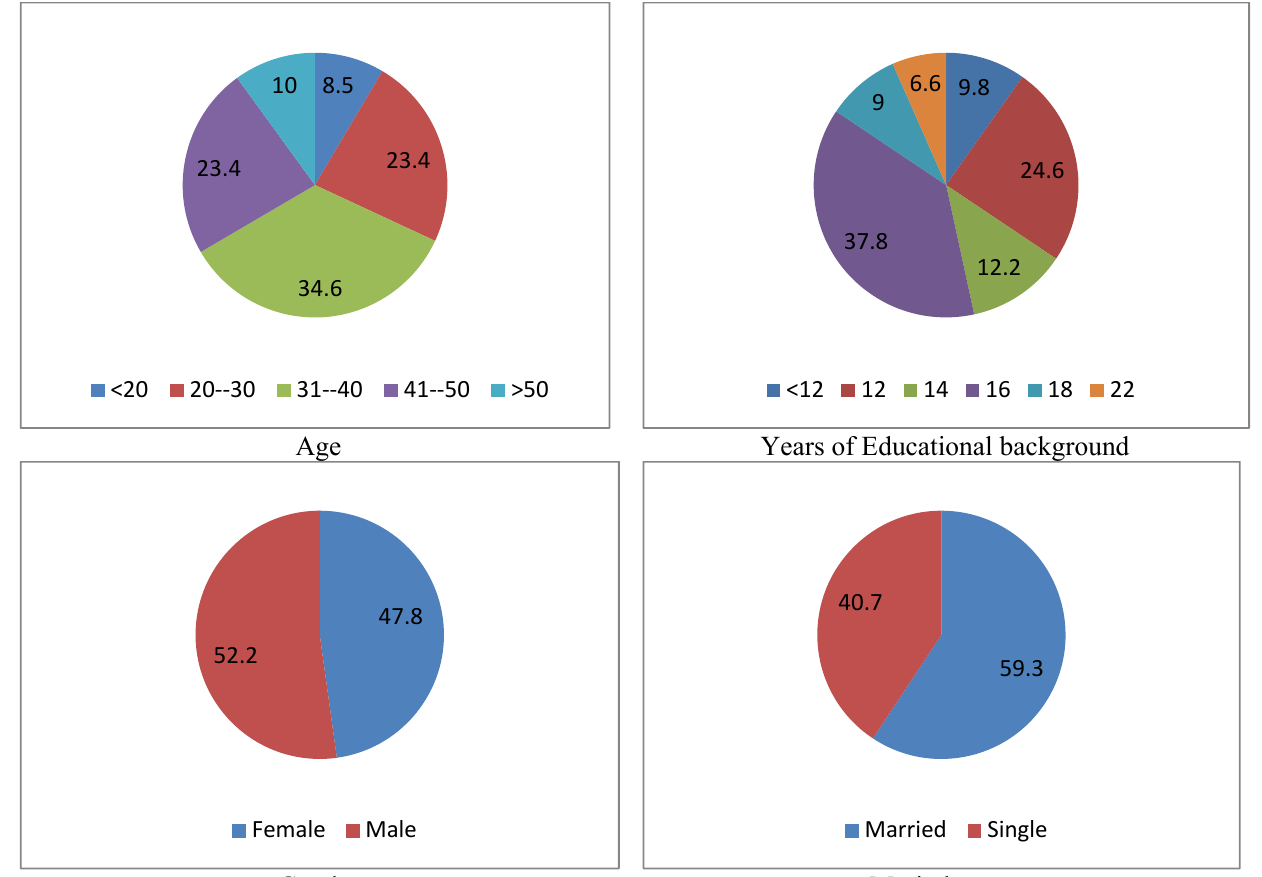
Fig. 2. Personal characteristics of participants